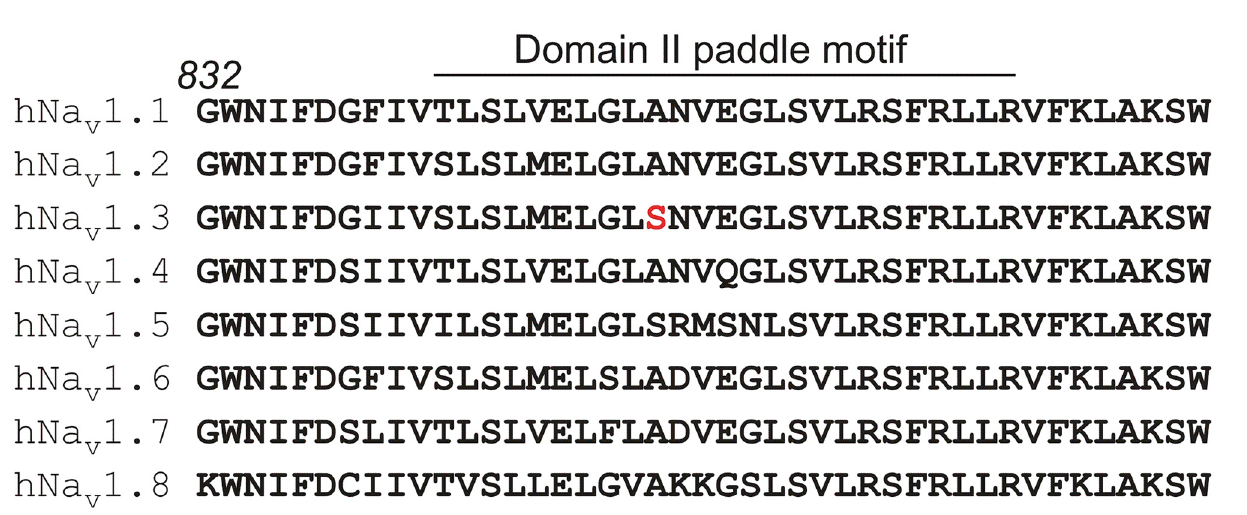
Fig 5. Sequence alignment of the domain II paddle motif in 8 mammalian Na v channel isoforms. Figure shows a sequence alignment of the domain II paddle motif as found in 8 mammalian Na v channel isoforms. As a reference, the number in italic indicates the coordinates of the first Gly residue in hNa v 1.1. Although the Ile in hNa v 1.3 (position 830 according to hNa v 1.3 coordinates, 840 according to hNa v 1.1 coordinates) differs from the Phe found in other neuronal isoforms, this residue is not present within the paddle motif and may not be accessible to Tf2. The Ser at position 842 (hNa v 1.3 coordinates — indicated in red) is unique among hNa v 1.1 – 1.3.